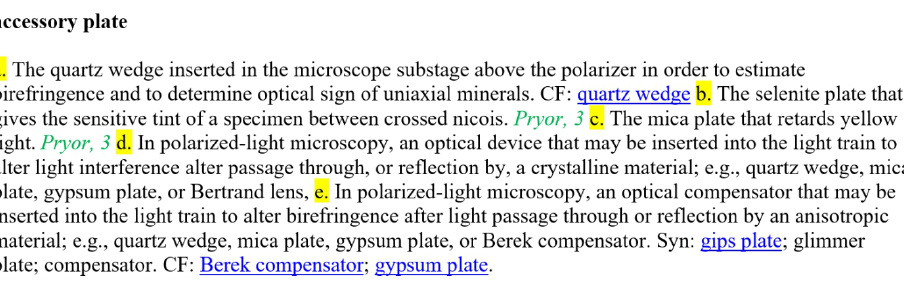
Figure 2. An example of scanned entry from